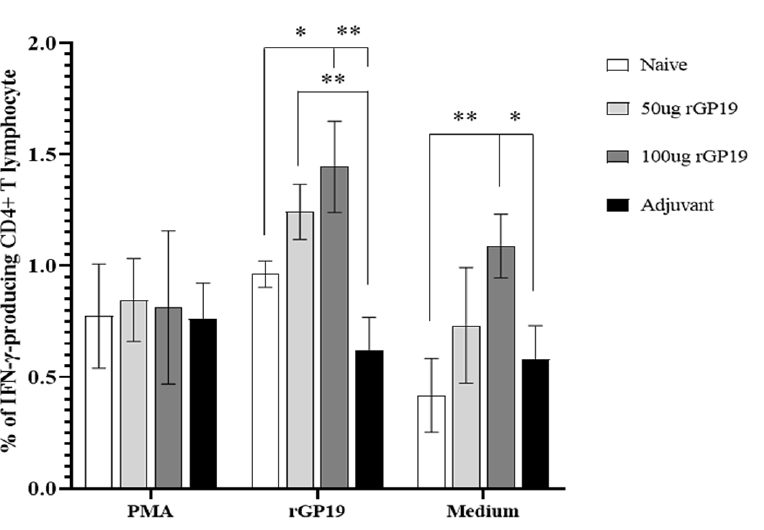
Figure 6. Mean of the frequencies of IFN- γ -producing CD4+ T lymphocytes in the splenocytes of mice on days 14 post- Ehrlichia canis infection when stimulated with different treatments. Data are represented as mean ± SE, one-way ANOVA, * p < 0.05, ** p < 0.01.